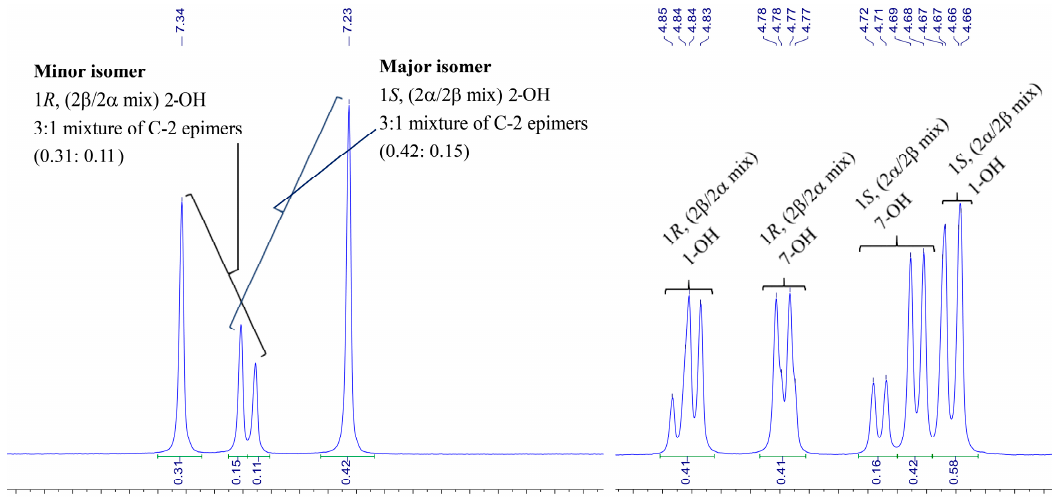
Figure 3. The ratio of the isomers mixture of 7 .